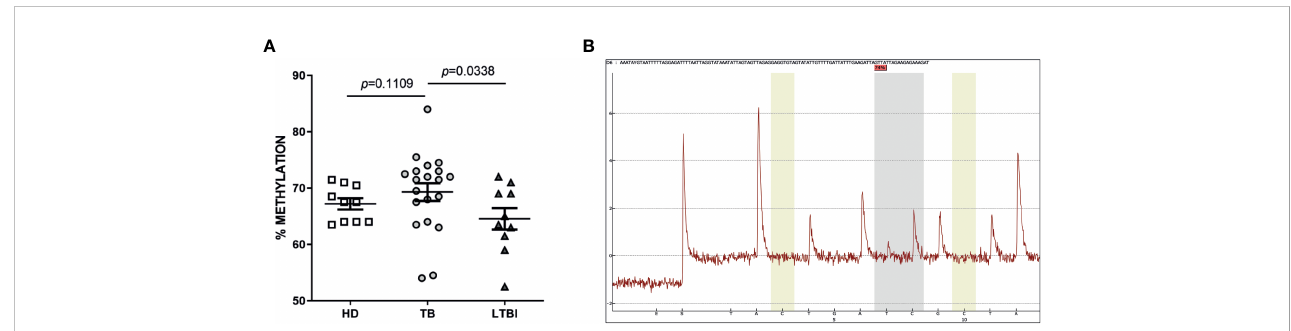
FIGURE 3 Methylation status of the -53 CpG of IFNG promoter in whole blood. Genomic DNA was obtained from whole blood from HD, TB patients and LTBI. Bisul fi te converted-DNA was ampli fi ed by PCR and pyrosequencing was performed to determine the degree of methylation at the -53 CpG site of the IFNG promoter. (A) P values were calculated by one way ANOVA for non-parametric data and Dunn ’ s multiple comparison test. (B) A representative pyrogram is shown.